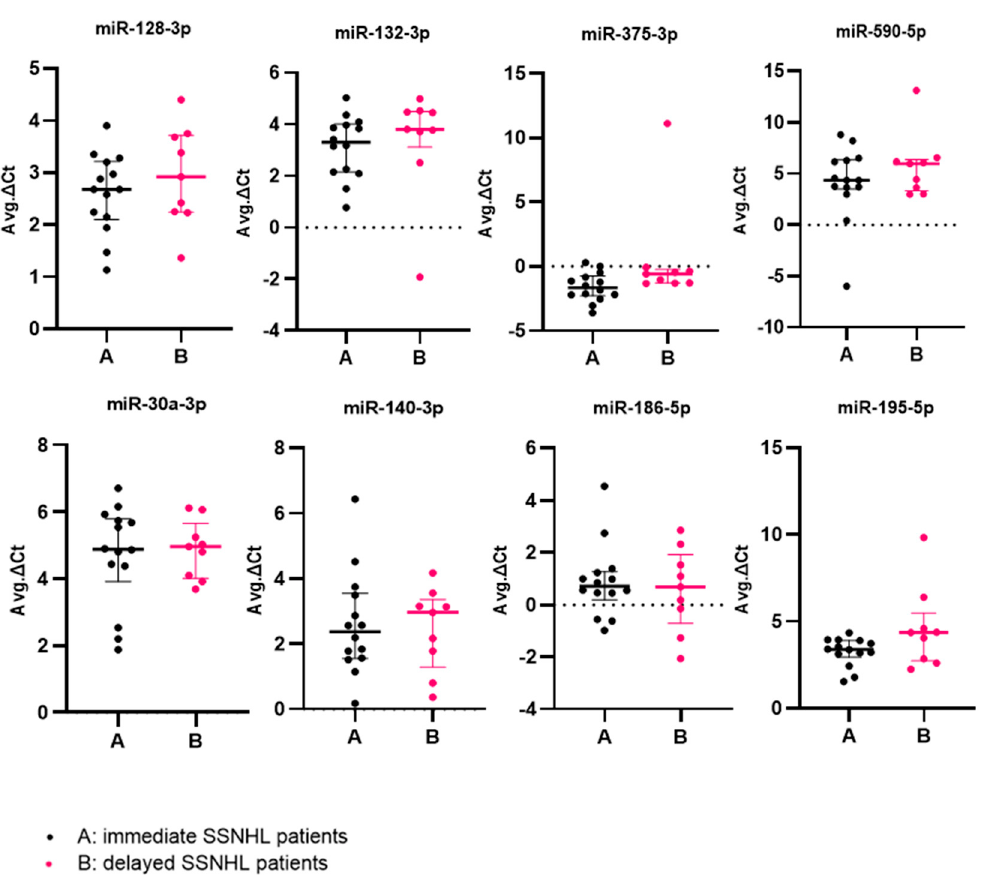
Figure 1. MicroRNA expression levels were the average of triplicate PCR runs for each miRNA in both groups. Box-plots of expression levels of miR-30a-3p, miR-128-3p, miR-132-3p, miR-375-5p, miR-590-5p, miR-140-3p, miR-186-5p, and miR-195-5p in sudden sensorineural hearing loss (SSNHL) immediate (A) and delayed (B) group patients. The central bar marks the median value, and the upper and lower bars, the 25th and 75th centile values. There was no significant difference in expression levels of these miRNAs between immediate and delayed group patients.